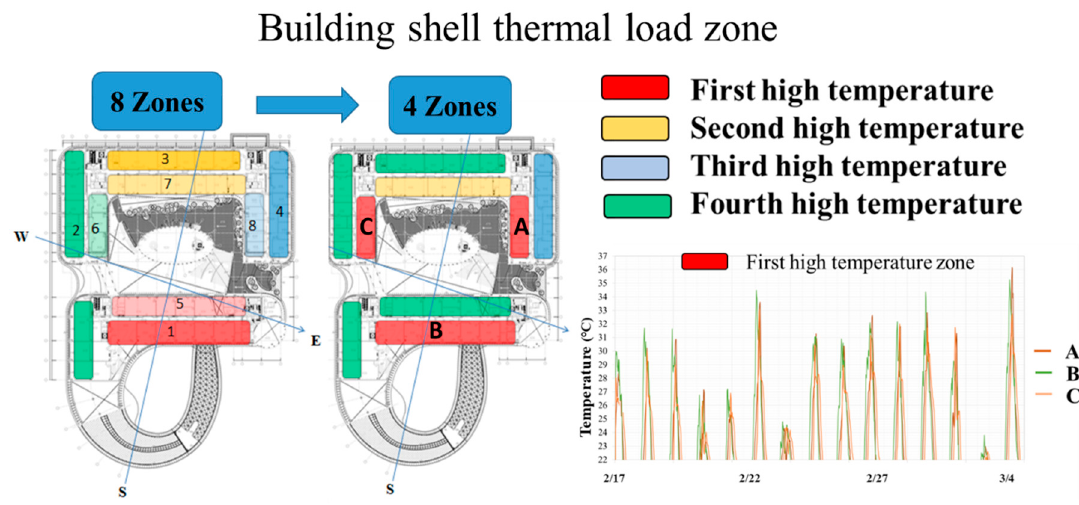
Figure 4. Orientation of the rooms.